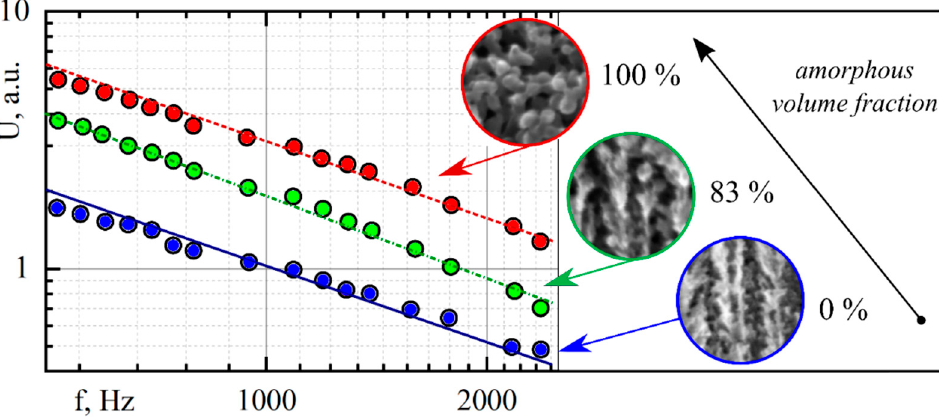
Figure 6. The amplitude–frequency dependencies of the PA signal for the porous silicon samples with 75% porosity and amorphous fractions of 0%, 83%, and 100%. The insets show the 200 nm region of the cross-sectional views of the porous silicon layer, obtained by SEM.